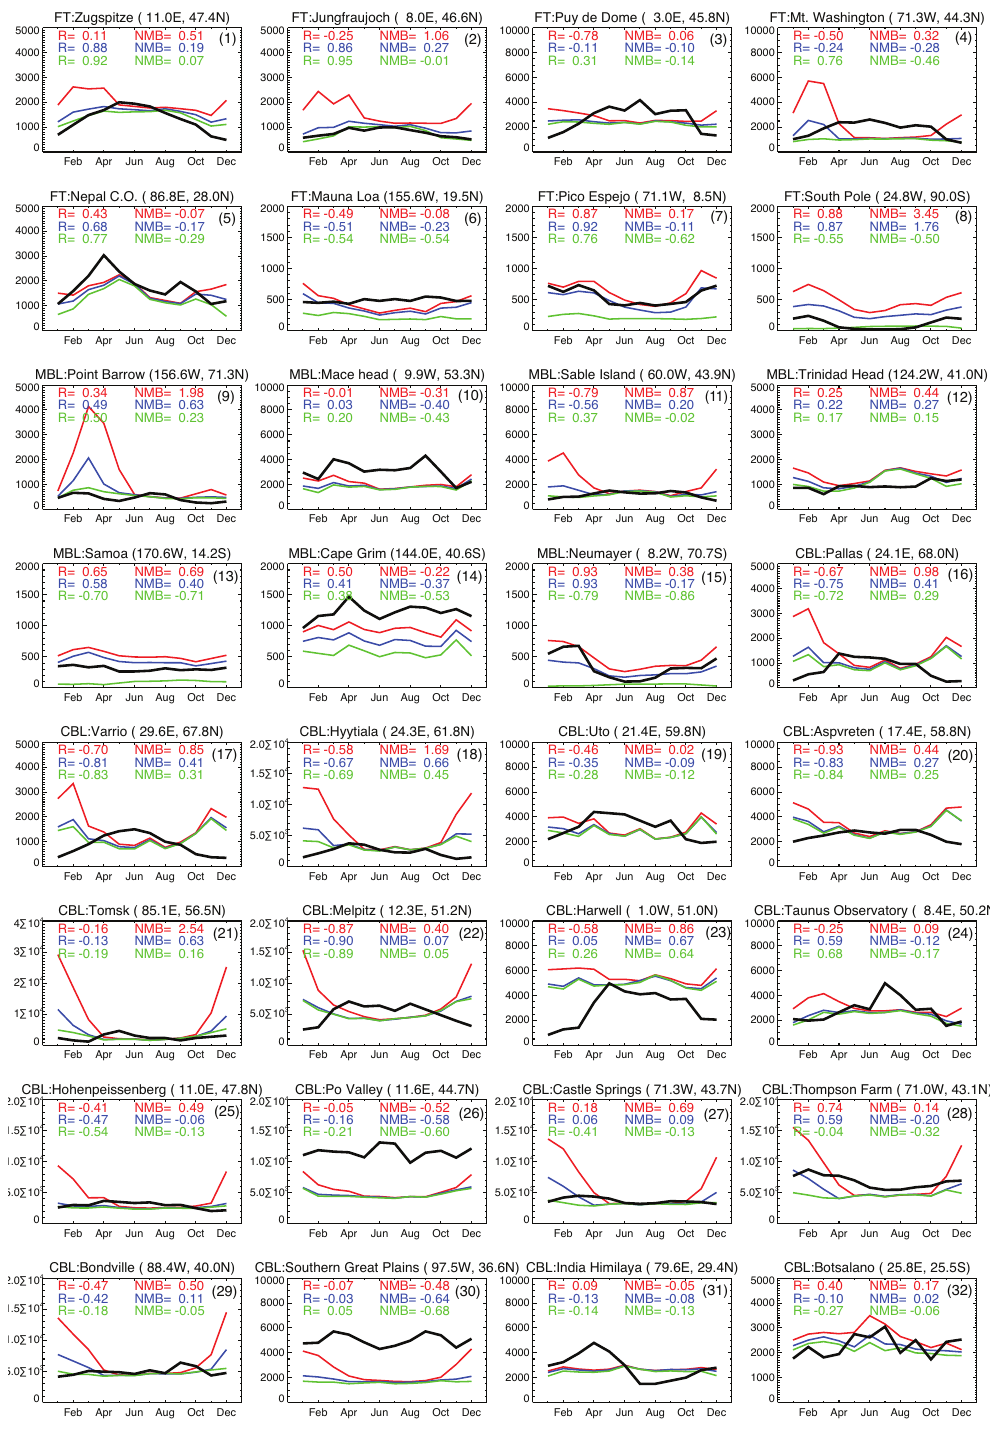
Figure 22. Annual cycle of aerosol number concentrations (cm − 3 at ambient conditions) at 32 sites. The observations are shown in black, and three model results are presented: red for BASE, blue for LowNUC, and green for NoNUC. The free tropospheric (FT) sites are from 1 to 8; the marine boundary layer (MBL) sites, 9 to 15; and the continental boundary layer (CBL) sites, 16 to 32. Correlation ( R ) and normalized mean bias (NMB) are provided only when the observation is available for 12